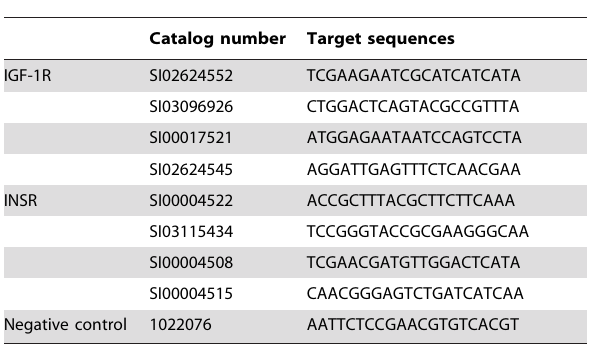
Table 1. GeneSolution a siRNA target